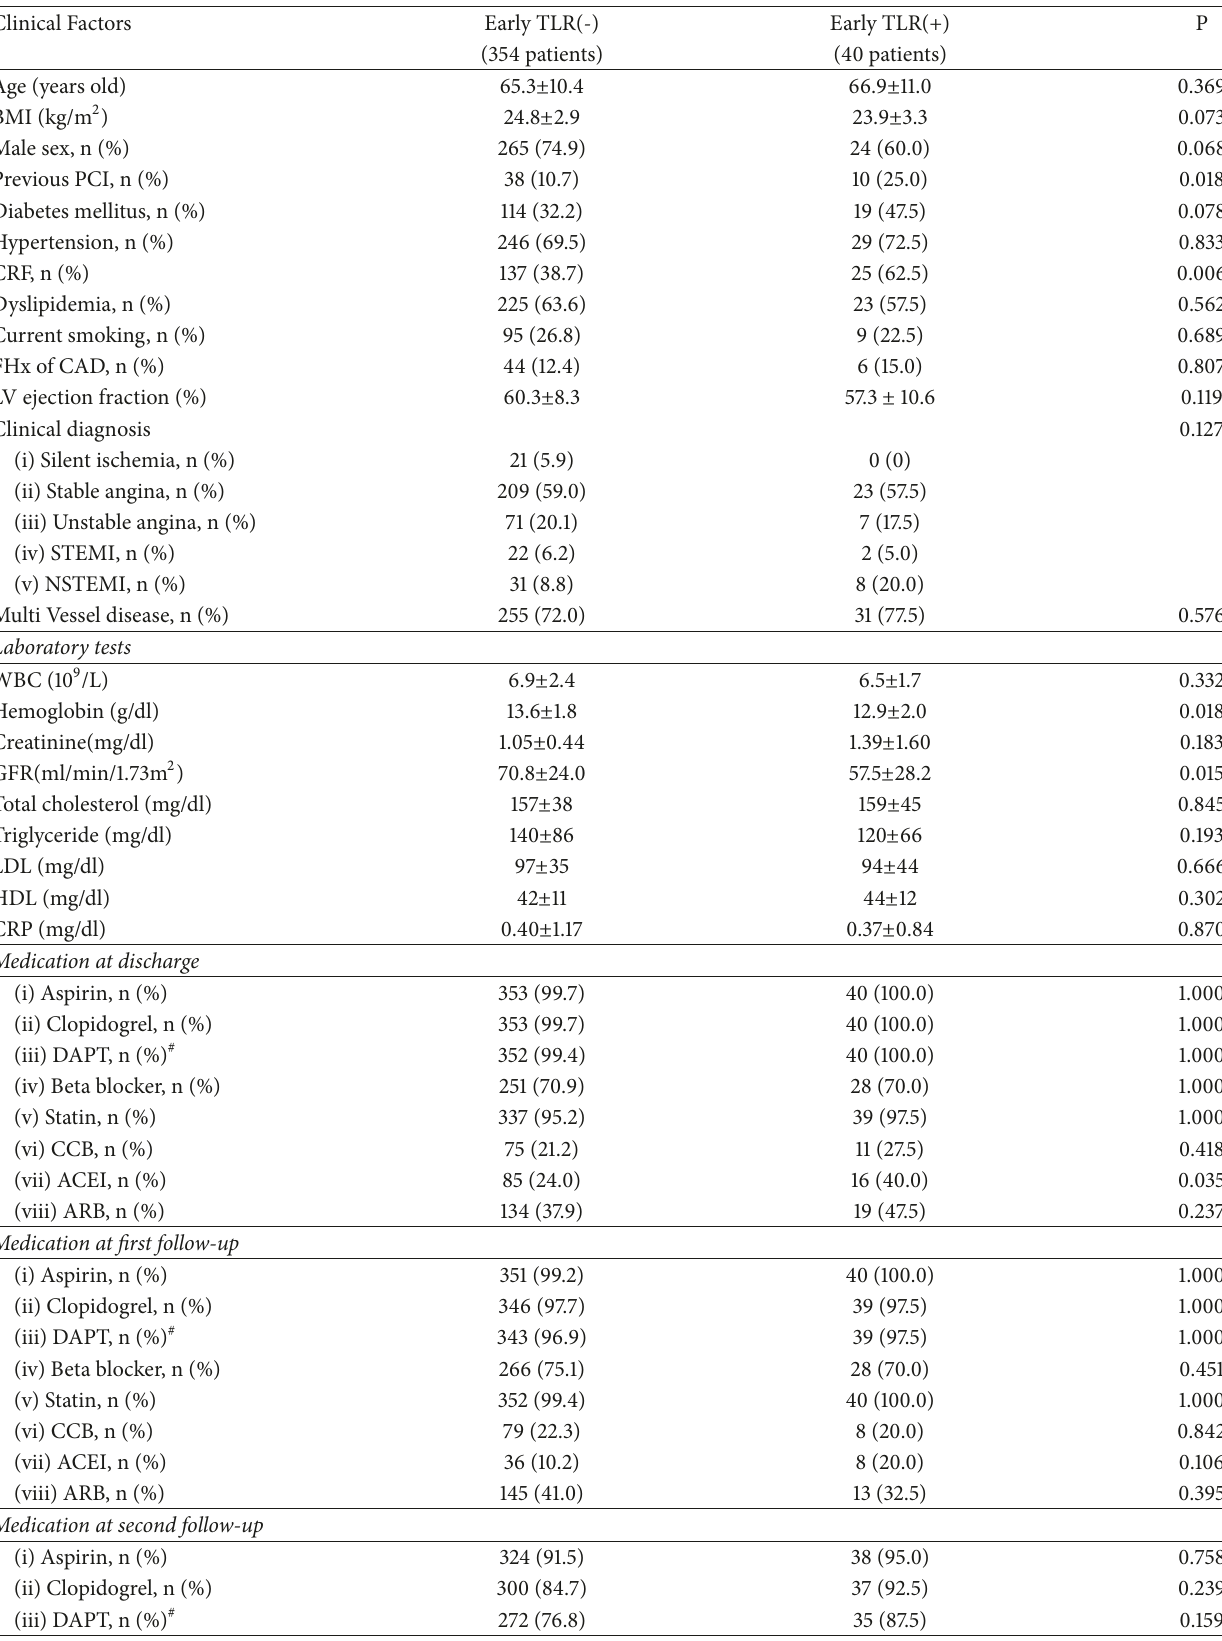
Table 1: Baseline patients and lesion characteristics according to early TLR. Clinical